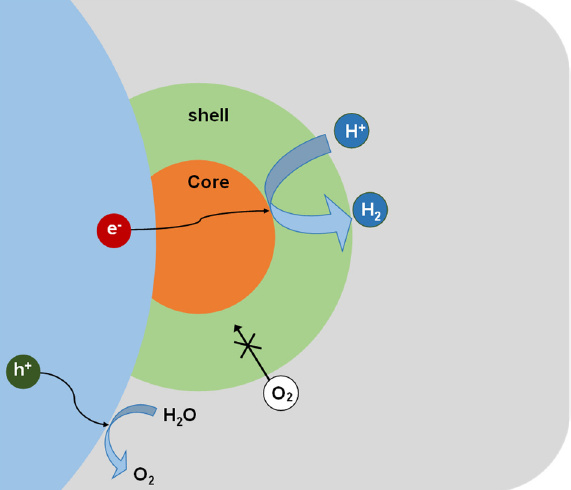
Figure 7. Core–shell structured cocatalyst.